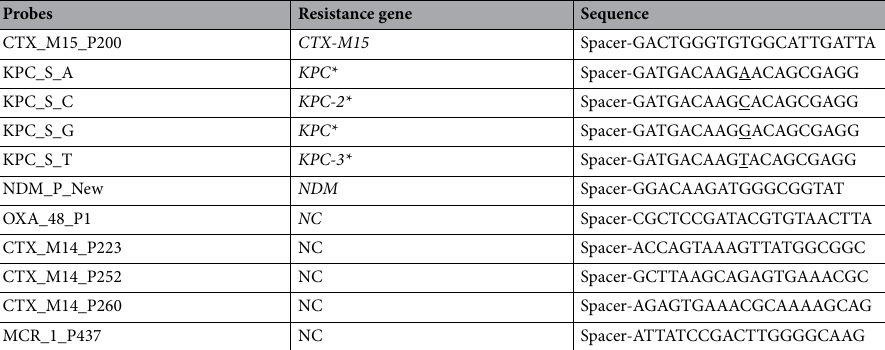
Table 2. List of immobilized probes. Illustration of the specific and unspecific (negative control; NC) probes used for the hybridization and detection of the RPA amplicons via microarray. The spacer consists of an aminohexyl-linker followed by an poly(T)-sequence. All probes were synthesized and provided by metabion international AG. (*reference: Peter et al. 26